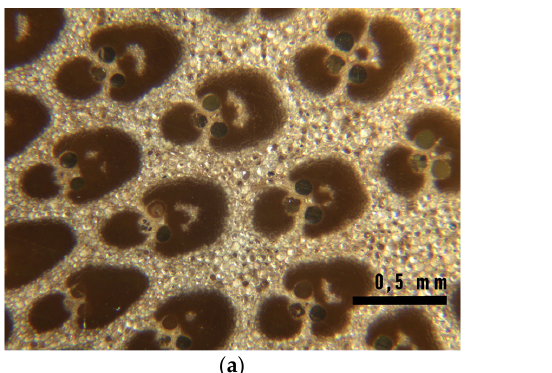
Figure 14. Backscattered electrons ESEM micrograph of the longitudinal section of an aged sample (192 h), taken from the external surface ( a , on the left) to the inner surface ( b , on the right) of the culm wall.